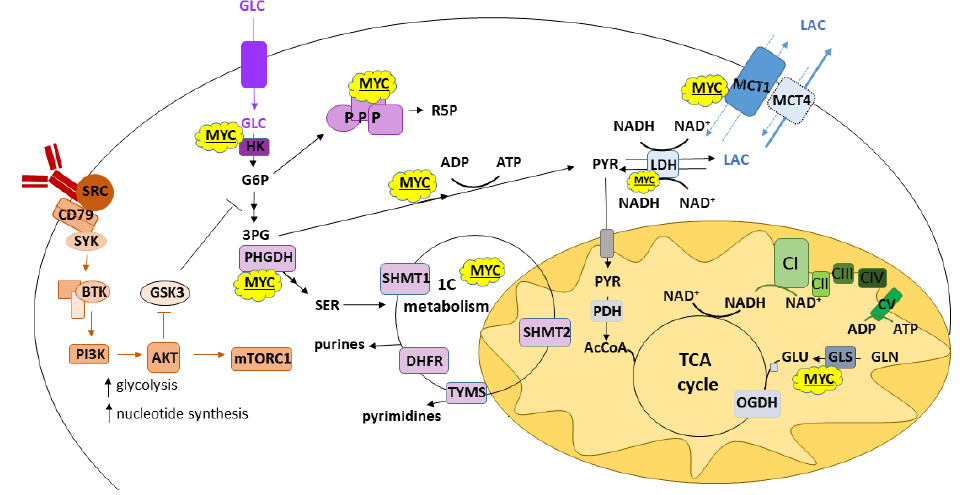
Figure 1. Metabolic pathways in B-cell lymphoma. Imported glucose (GLC) is metabolized via glycolysis with multiple branching pathways utilizing glycolytic intermediates and pyruvate (PYR): glucose-6-phosphate (G6P) can be metabolized via the pentose phosphate pathway (PPP) to ribose-5-phosphate (R5P); 3-phosphoglycerate (3PG) can be used for serine (SER) and glycine (not shown) synthesis and contribute to one-carbon (1C) metabolism and the synthesis of purines and pyrimidines; glycolytic pyruvate can be converted to lactate (LAC) (while regenerating NAD + ) and exported out of the cell or metabolized further in mitochondria and enter the tricarboxylic acid (TCA) cycle as acetyl coenzyme A (AcCoA). Glutamine (GLUT) conversion to glutamate (GLU) is one of anaplerotic pathways that can feed the TCA cycle. These metabolic pathways are regulated at multiple levels and via several modes such as kinase signaling triggered by BCR activation (shown in orange) and transcription factor MYC (shown as yellow clouds). Other abbreviations used in the figure: Bruton tyrosine kinase (BTK), phosphoinositide-3-kinase (PI3K), glycogen synthase kinase 3 (GSK3), mammalian target of rapamycin complex 1 (mTORC1), hexokinase (HK), phosphoglycerate dehydrogenase (PHGDH), serine hydroxymethyl transferase 1/2 (SHMT1/2), dihydrofolate